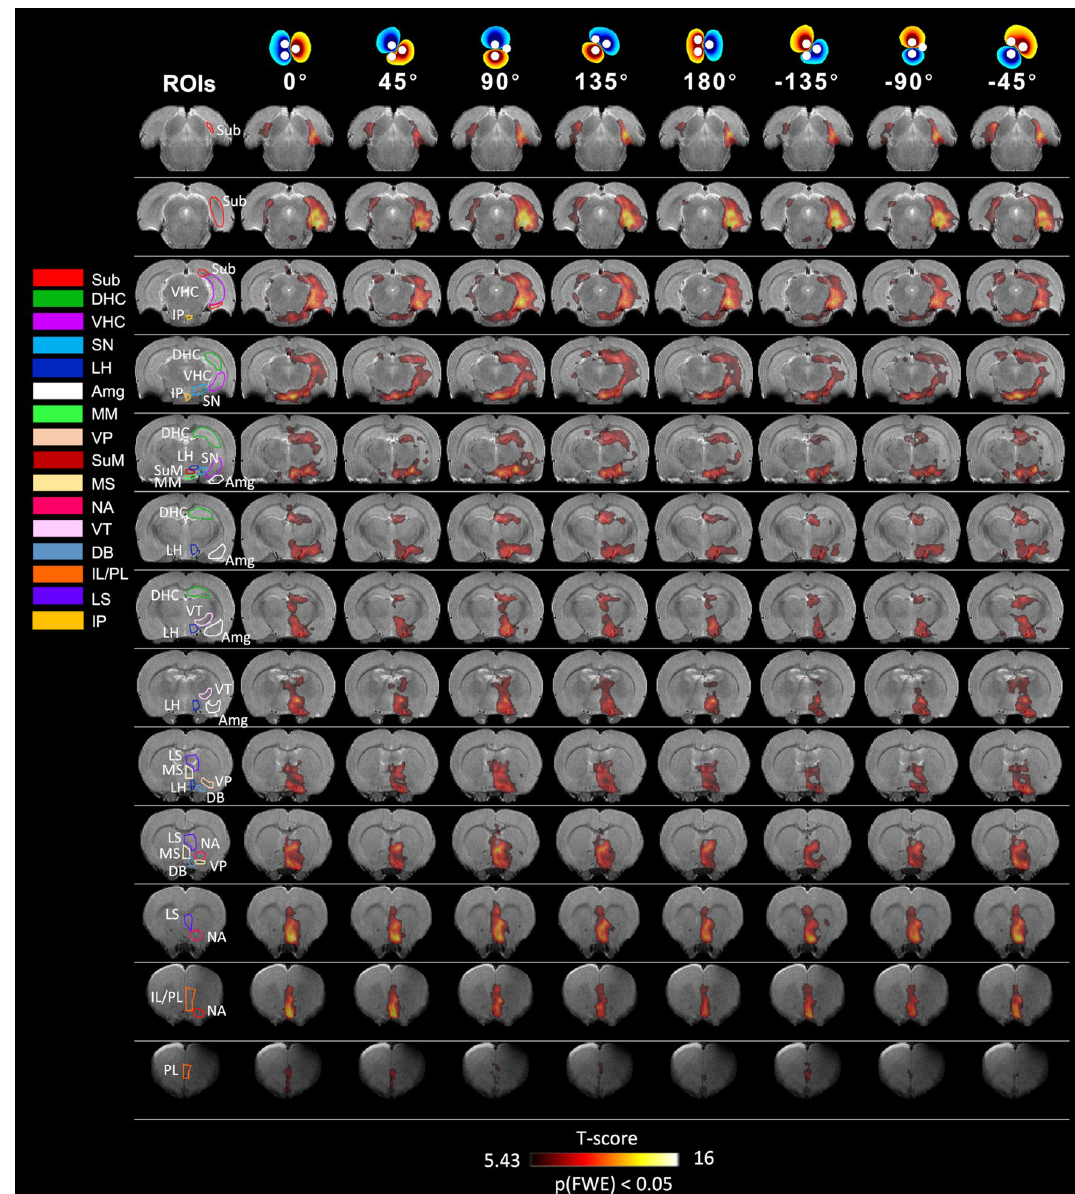
Figure 4. Main effects of OS-DBS in the MSN for all stimulation angles (n = 8). Maps were obtained by the one-way within subject ANOVA model (p < 0.05, FWE corrected). Stimulation angles are indicated on the top. Amg: amygdala, DB: diagonal band, DHC: dorsal hippocampus, VHC: ventral hippocampus, LH: lateral hypothalamus, IL/PL: infralimbic/prelimbic cortices, LS: lateral septum, MM: mammillary bodies; MS: medial septum, NA: nucleus accumbens, SN: substantia nigra, Sub: subiculum, SuM: supramamillary nuclei, VP: ventral pallidum, VT: ventral tegmental area, IP: interpeduncular nucleus. Coronal brain images are displayed in neurological convention (left corresponds to the left side of the brain). Stimulation angles are shown on top. Stimulation frequency was 130